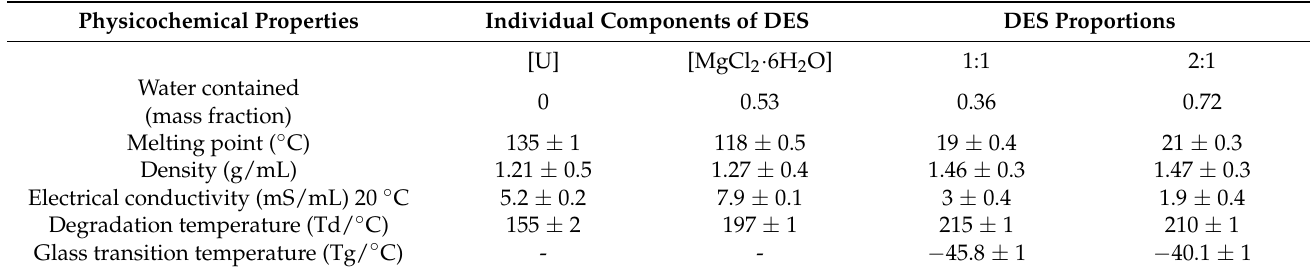
Table 1. Characteristics of prepared DES [MgCl 2 · 6H 2 O][U] proportions 1:1 and